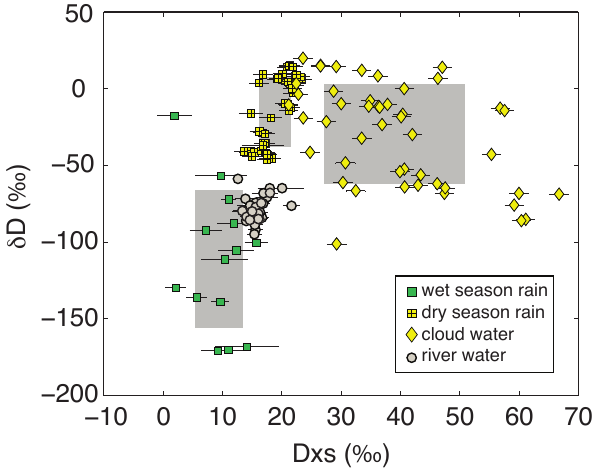
Figure 5. Hydrogen isotope ratio ( δ D, ‰) and deuterium excess (Dxs, ‰) of dry-season cloud water vapour (yellow diamonds), and river water (grey circles) from the Kosñipata catchment. Rainwater samples (squares) are from the dry season (May to August, yellow) and from the wet season (December to March, green). All error bars correspond to 2 standard deviations. The grey shaded regions en- compass the mean δ D and Dxs values and 1 standard deviation for each endmember (i.e. wet-season rainfall, dry-season rainfall, and dry-season cloud water vapour). The ranges defined by these grey boxes were used to generate random sets of endmember composi- tions for the three-endmember mixing